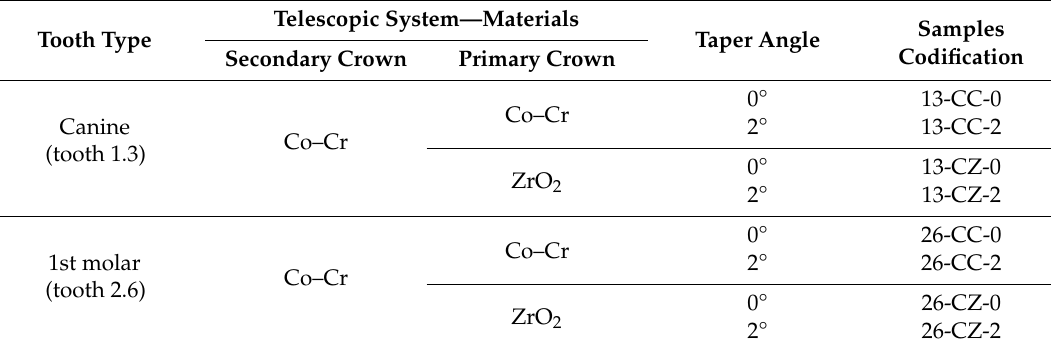
Figure 2. Research design, codification, and characteristic of the telescopic crowns obtained. Table 1. Codification of the obtained telescopic systems.